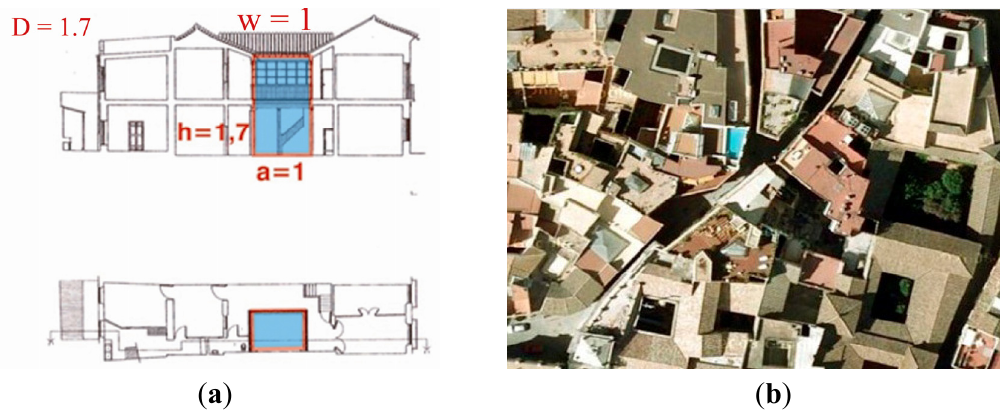
Figure 11. ( a ) House on Buitrón Street, Seville (Spain). Section and plan; ( b ) Seville aerial view.